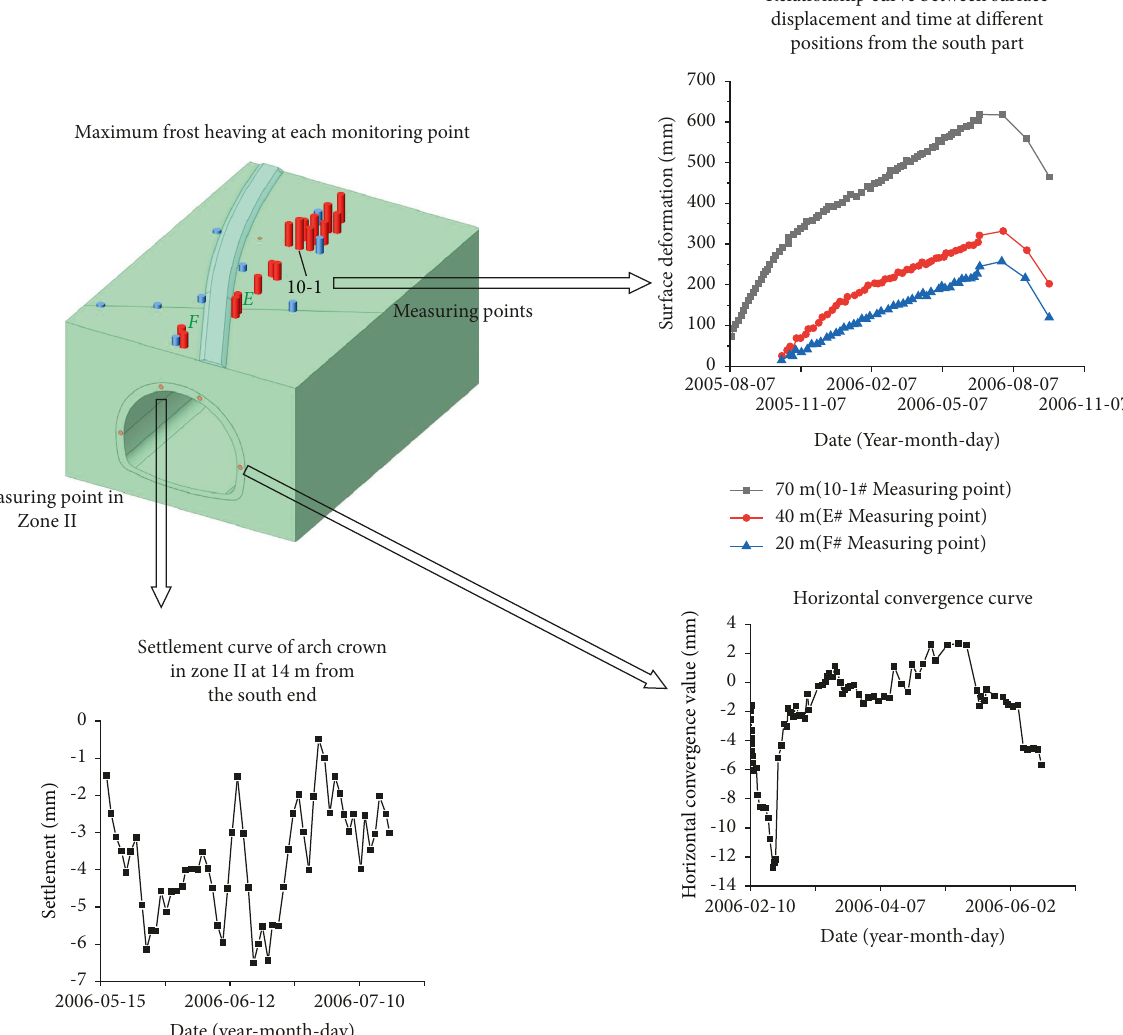
Figure 10: Surface deformation monitoring points and surface displacement curve, vault settlement, and horizontal convergence